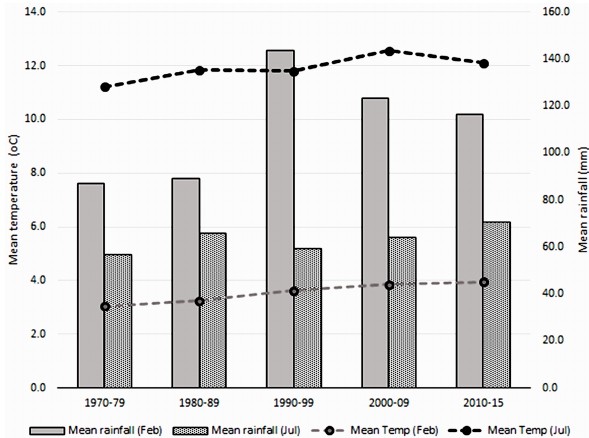
Figure 1. Climate trends in Shetland 1970–2015 (Met Office,